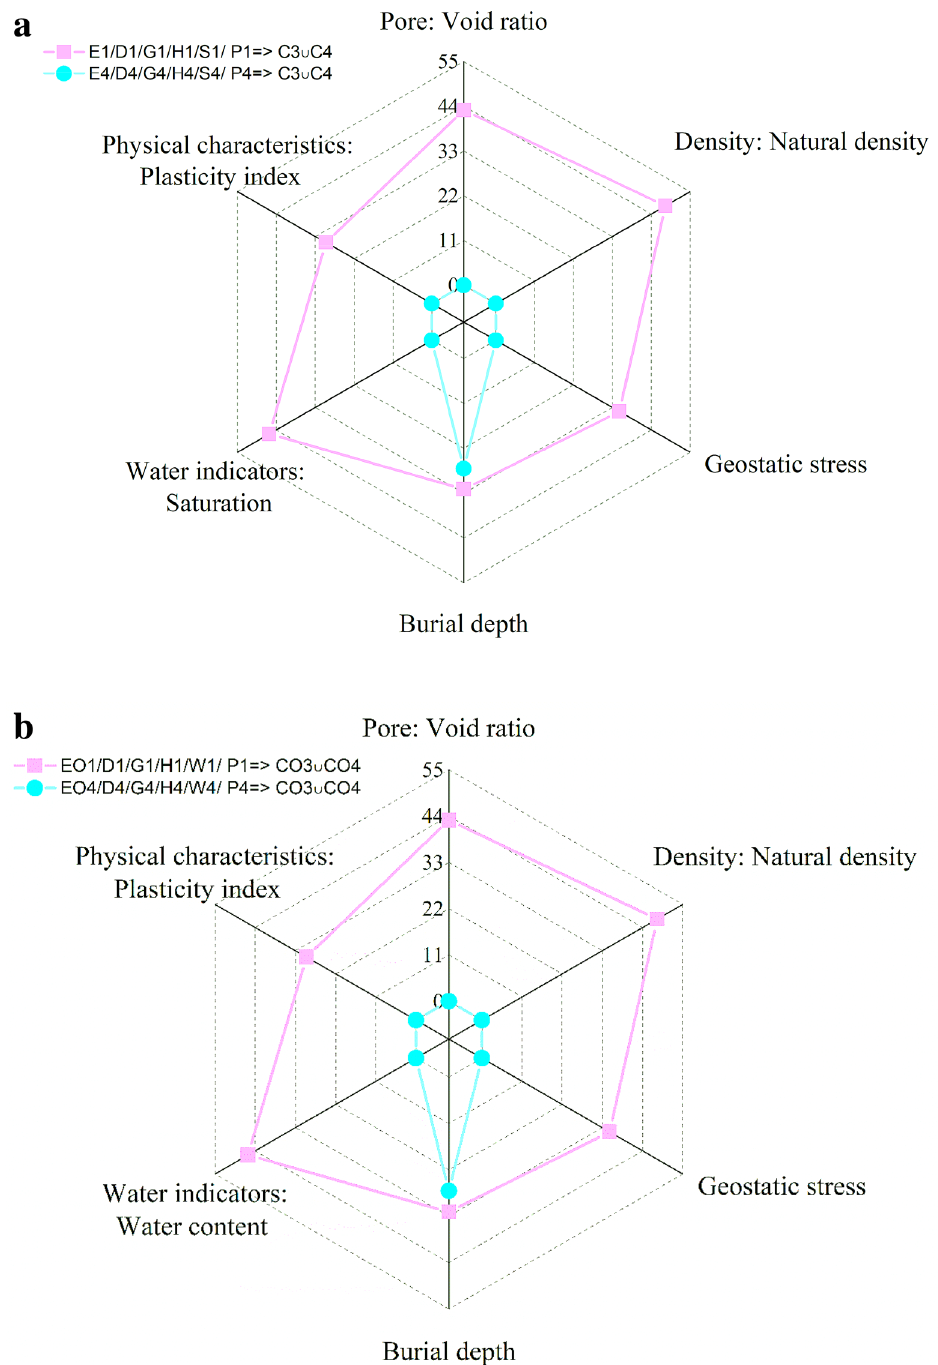
Figure 7. ( a ) Significant extracted association rules when δs = C3 or C4. ( b ) Significant extracted association rules when δzs = CO3 or